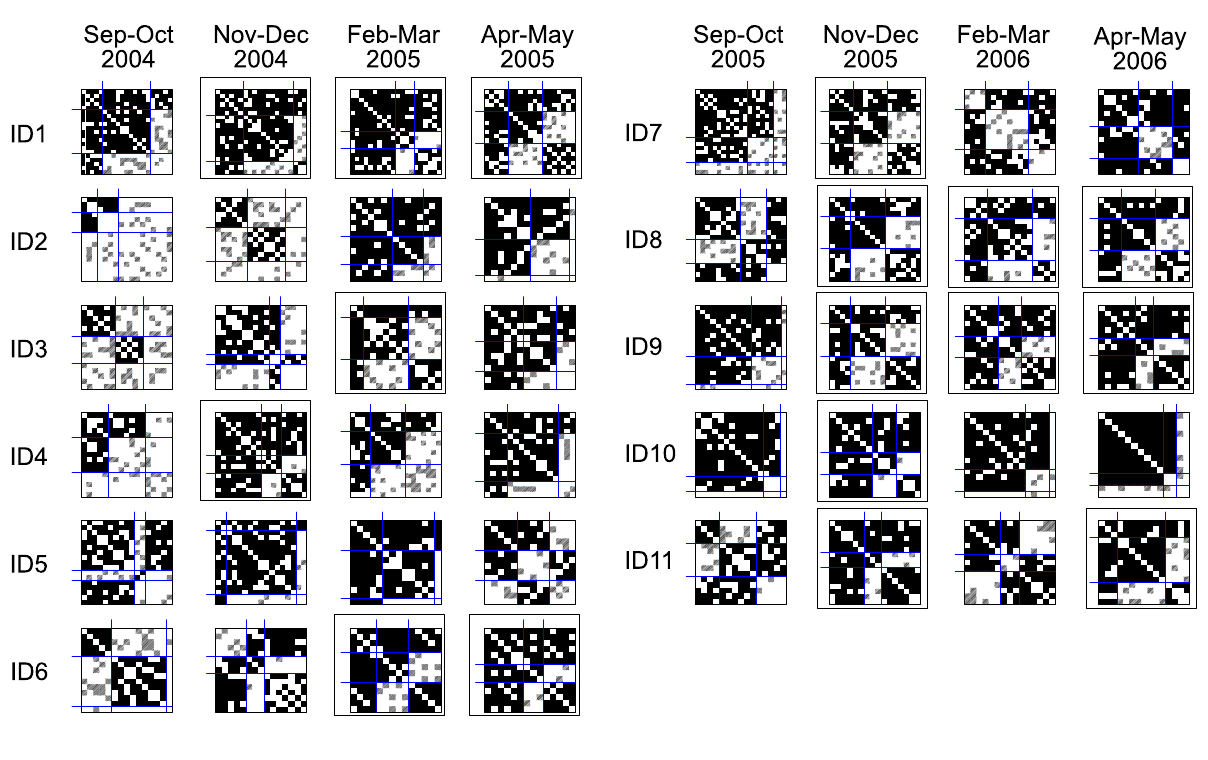
Fig 3. Obtained blockmodel structures for each class (ID1 to ID11) and each time period. Undirected and binarized empirical networks are considered. The obtained symmetric core-cohesive blockmodels are presented in the frame matrices.